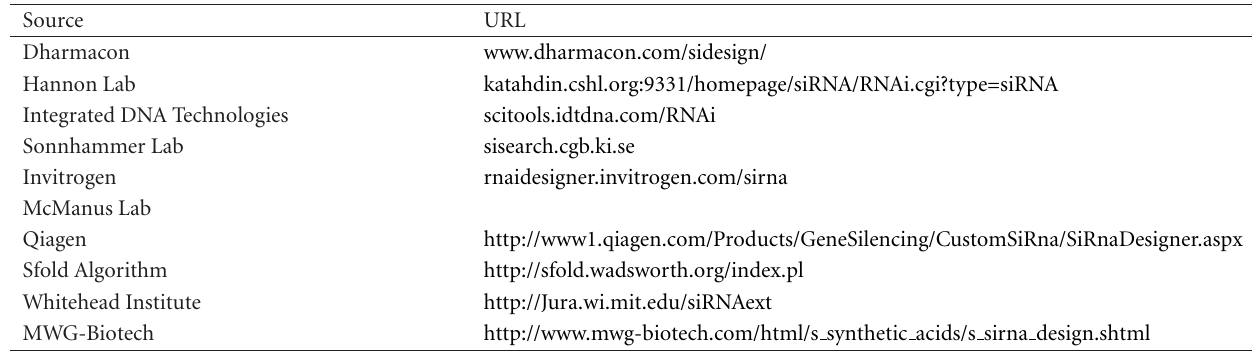
Table 2: Web sites for the design of e ff ective siRNAs (based on [24] with modifications). Source URL Dharmacon www.dharmacon.com/sidesign/ katahdin.cshl.org:9331/homepage/siRNA/RNAi.cgi?type =